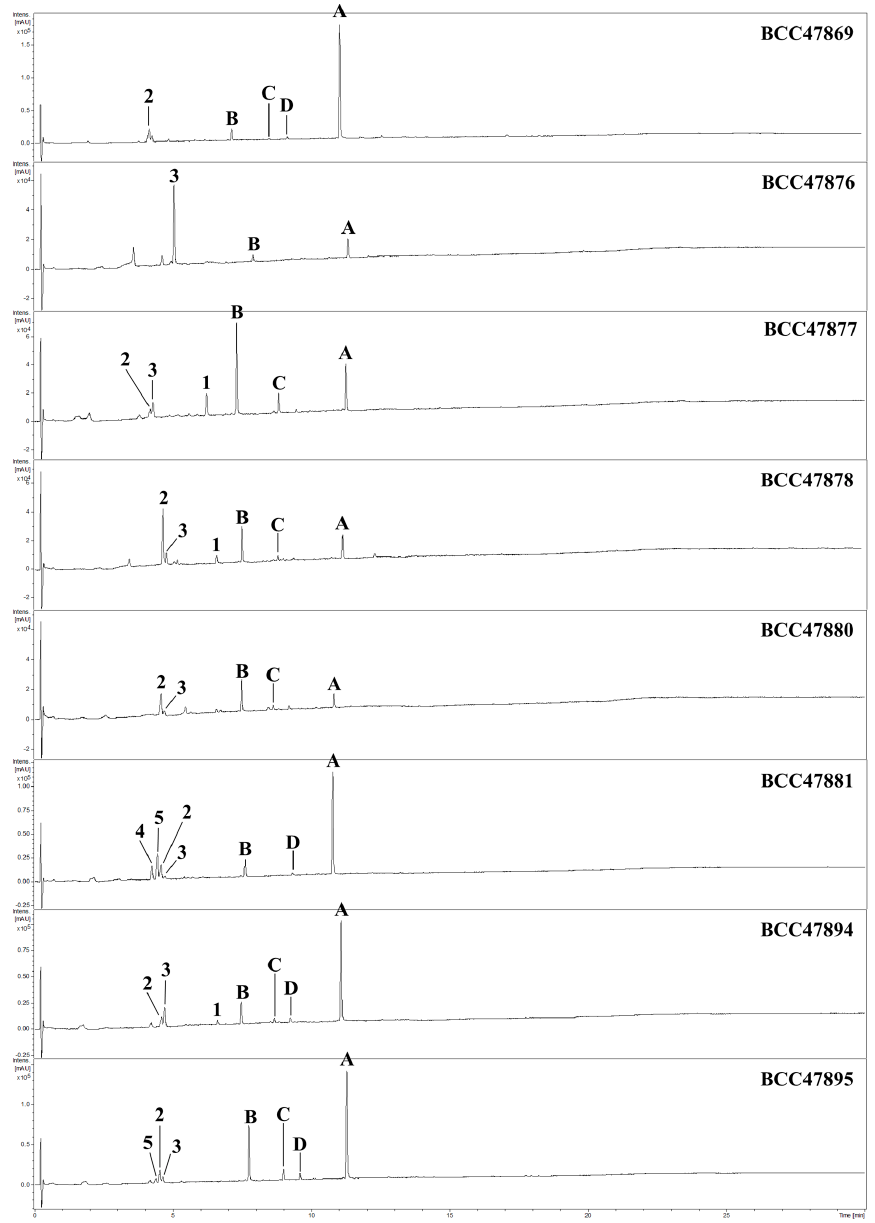
Figure 4. HPLC-UV profiles (200–600 nm) of A. novoguineensis isolates. Akanthol ( 1 ), akanthozine ( 2 ), Compound 3 ( 3 ), Compound 4 ( 4 ), Compound 5 ( 5 ), akanthopyrone A ( A ), akanthopyrone B ( B ), akanthopyrone C ( C ), and akanthopyrone D ( D ).